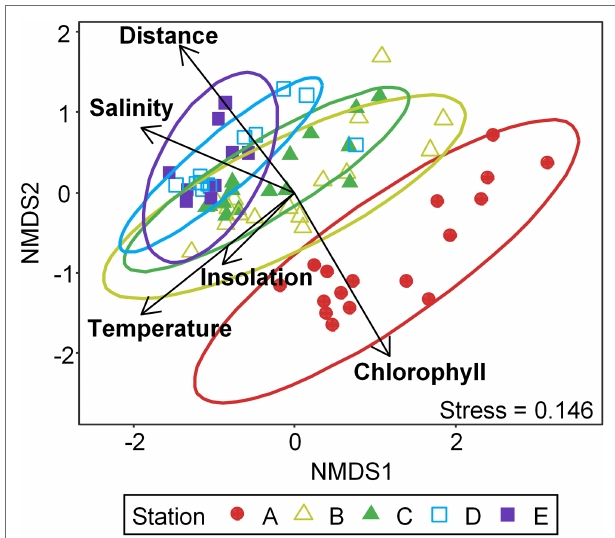
FIGURE 4 | Non-metric multidimensional scaling (NMDS) ordination based on Bray–Curtis dissimilarity of Labyrinthulomycete composition, fitted with the significant environmental factors (assessed by permutation tests in constrained ordination; p < 0.01). Temperature: seawater temperature; Chlorophyll: chlorophyll a ; Distance: distance from the shore; insolation: daily blue-sky insolation, which indicates the sampling date of the year. PERMANOVA tests identified significant dissimilarities ( p < 0.05) between the nearshore (station A), shelf (stations B and C), and offshore (stations D and E)